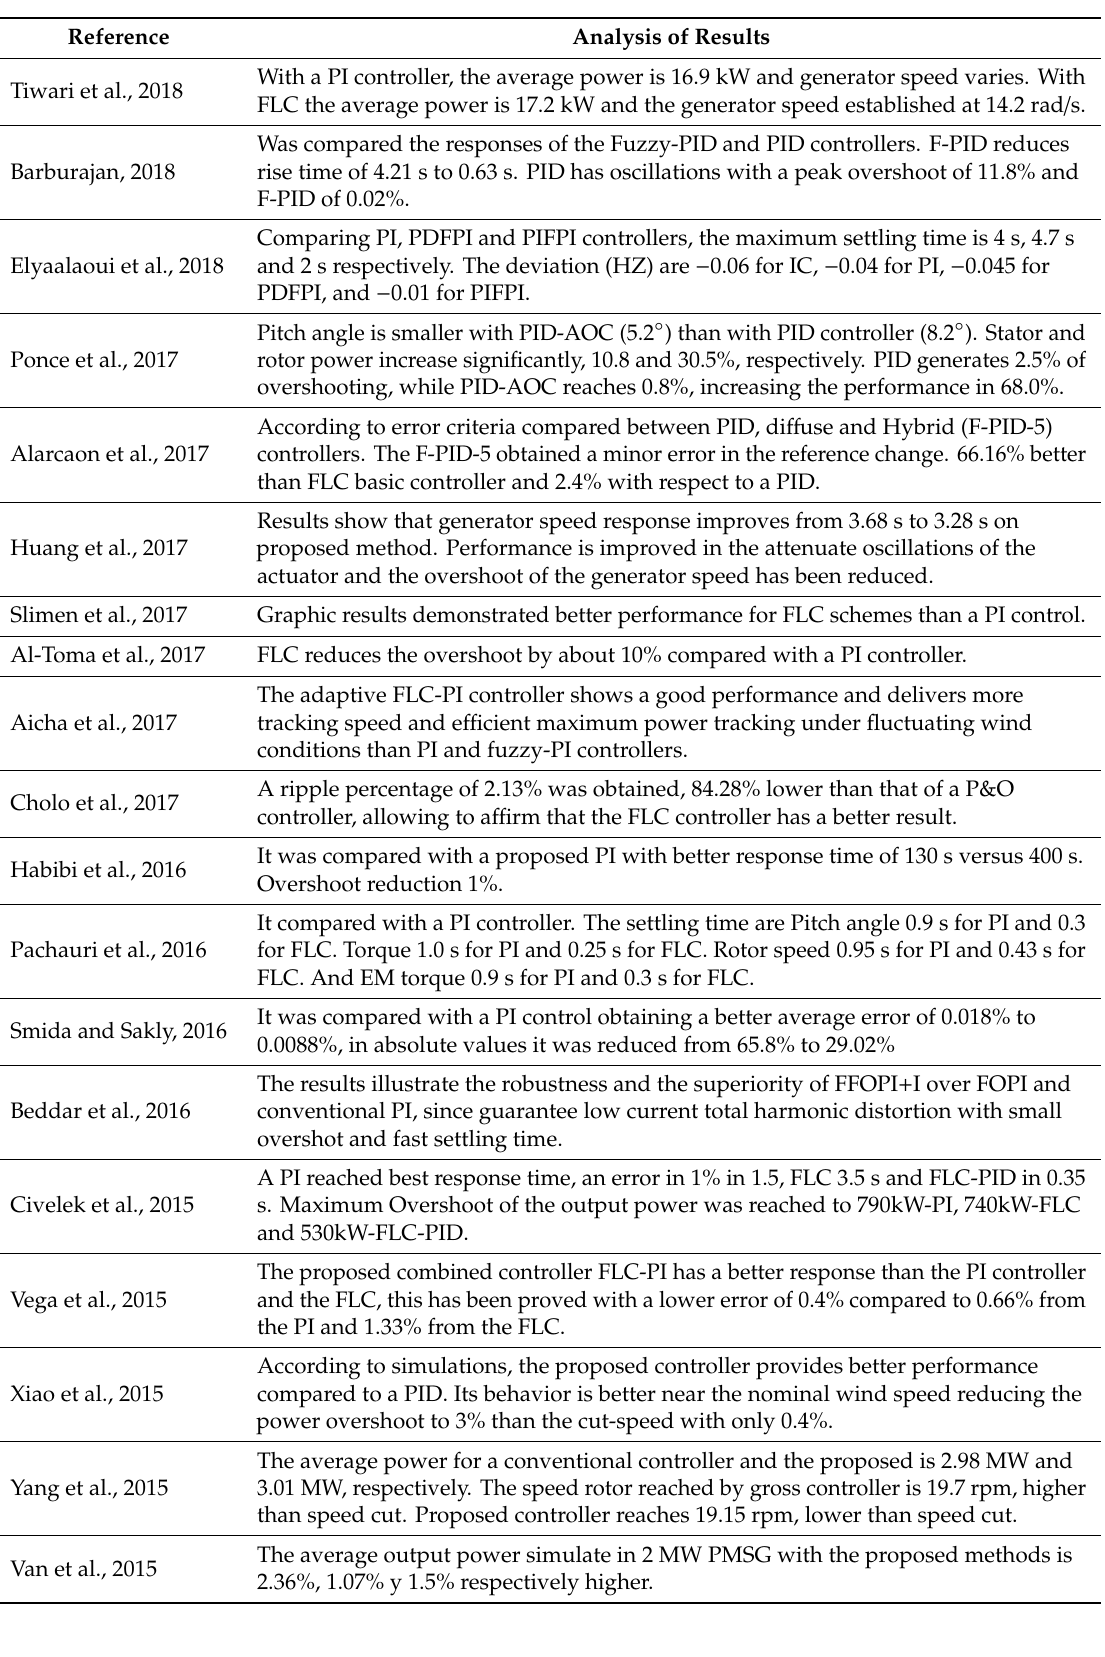
Table 2. Summary of works done with FLC